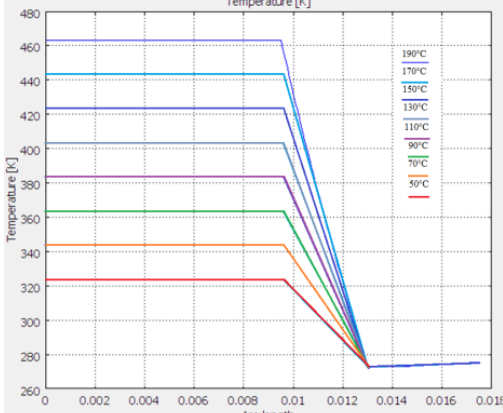
Figure 5. Distribution of temperature in cable section at different temperatures on a vein